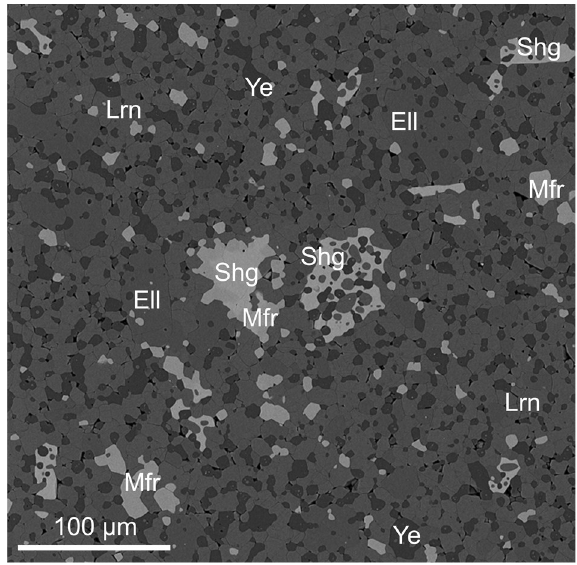
Figure 6. Xenomorphic sharyginite crystals in larnite-ye’elimite rock from Jabel Harmun. BSE image. Ell—fluorellestadite, Lrn—larnite, Mfr—magnesioferrite; Shg—sharyginite, Ye—ye’elimite.